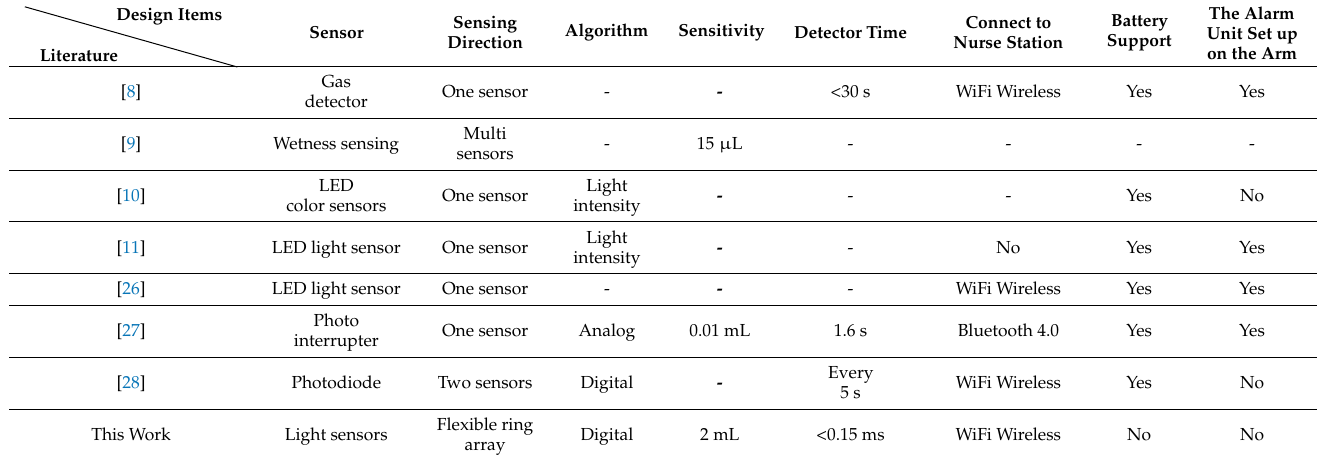
Table 3. Comparison of current work with previous systems in the